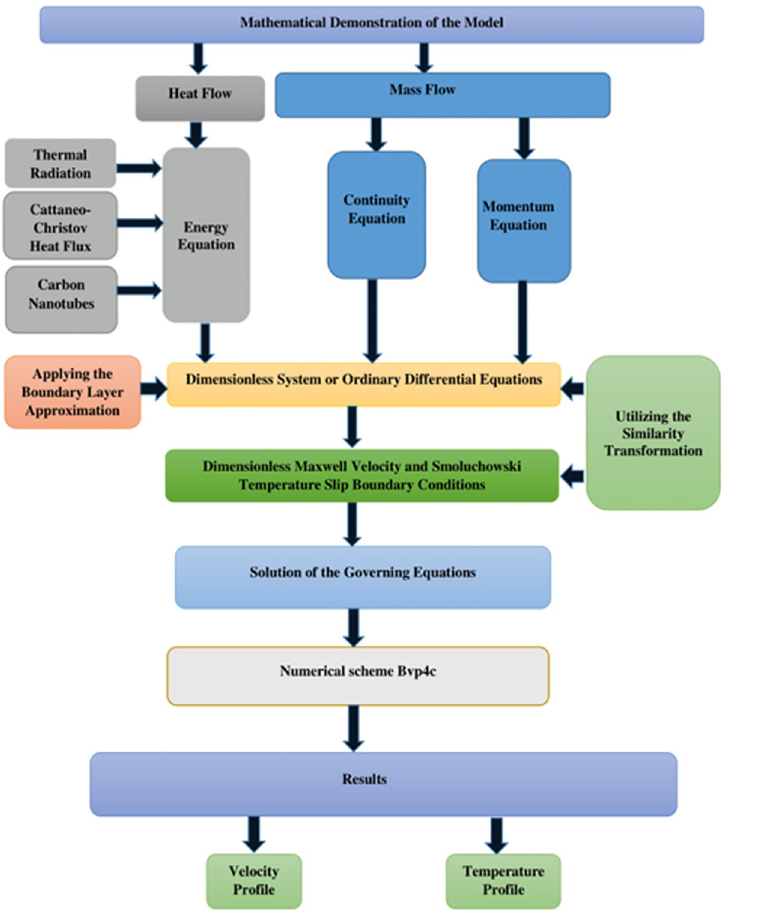
Fig 2. Mathematical model’s flow chart